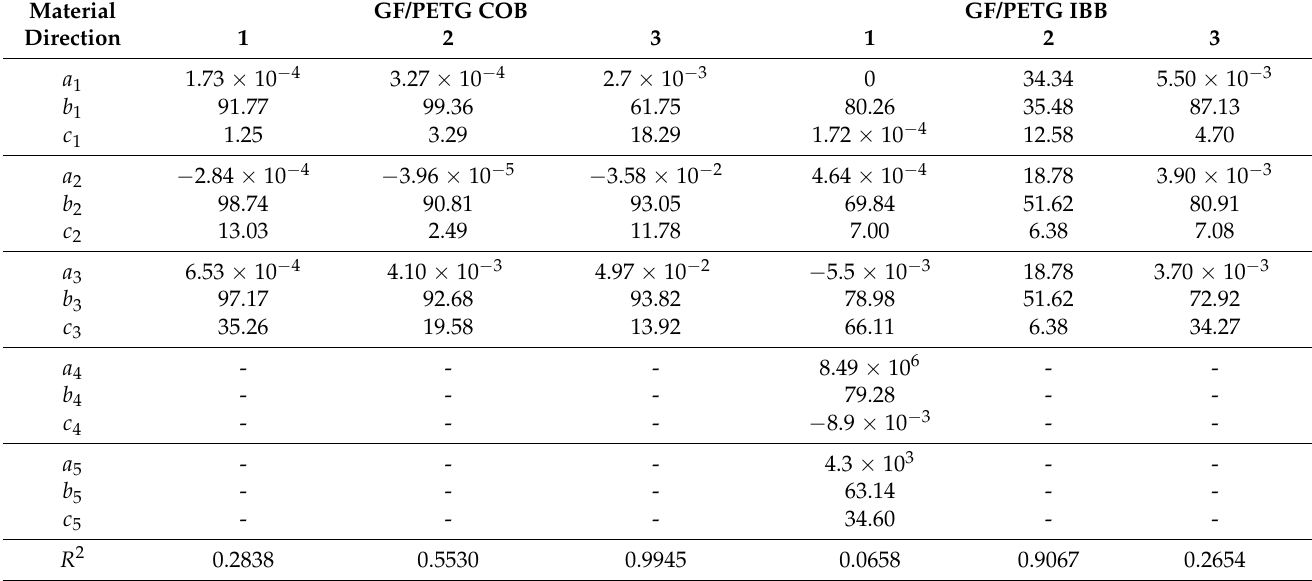
Table A3. Gaussian fitting parameters for GF/PETG material.